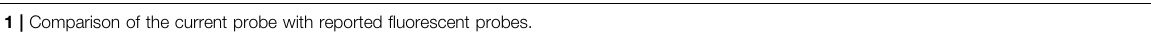
TABLE 1 | Comparison of the current probe with reported fl uorescent probes.